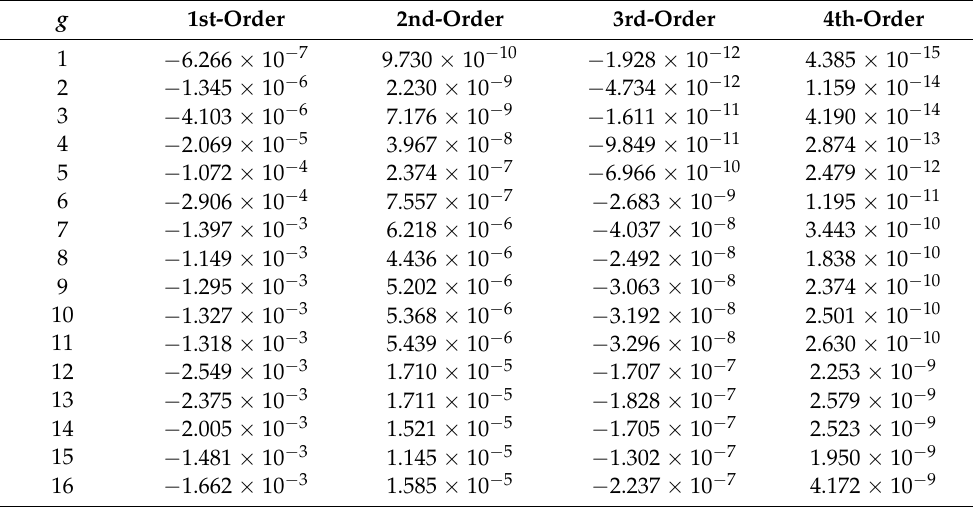
Table 5. Comparison of the 1st-order, 2nd-order, 3rd-order, and 4th-order unmixed relative sensitivi- ties, S ( 1 ) 4 ( 71